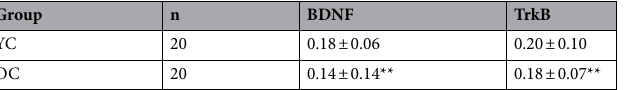
Table 2. A comparison on the average optical absorbance value of BDNF and TrkB immunoreactivity in the primary visual cortex of young and old cats (mean ± SD). **Indicates the average optical absorbance value of BDNF or TrkB immunoreactivity in the primary visual cortex was declined significantly in the old cats when compared with the young cats ( One way ANOVA , P < 0.01).